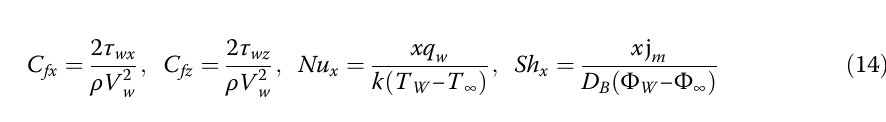
Fig. 9 Graph of concentration for various values of β h